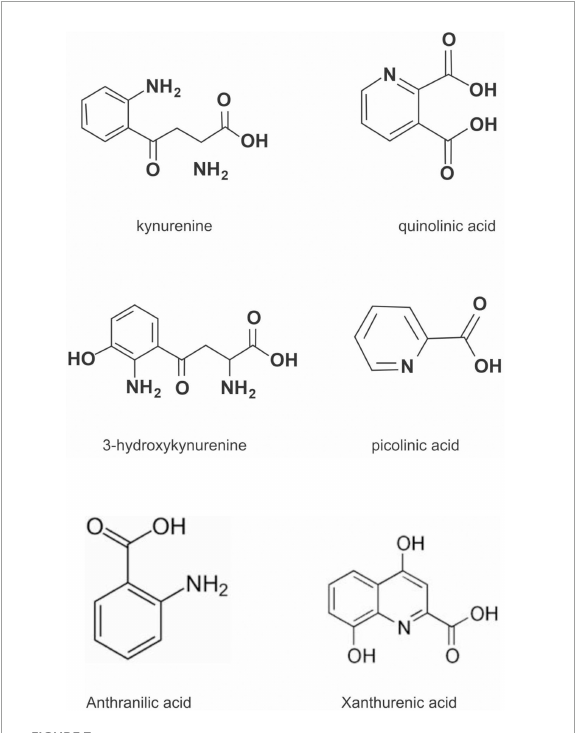
in more than 50% of tumors (239) including hematological malignancies. Like in solid tumors, hematological malignancies are known to create an immunosuppressive environment to